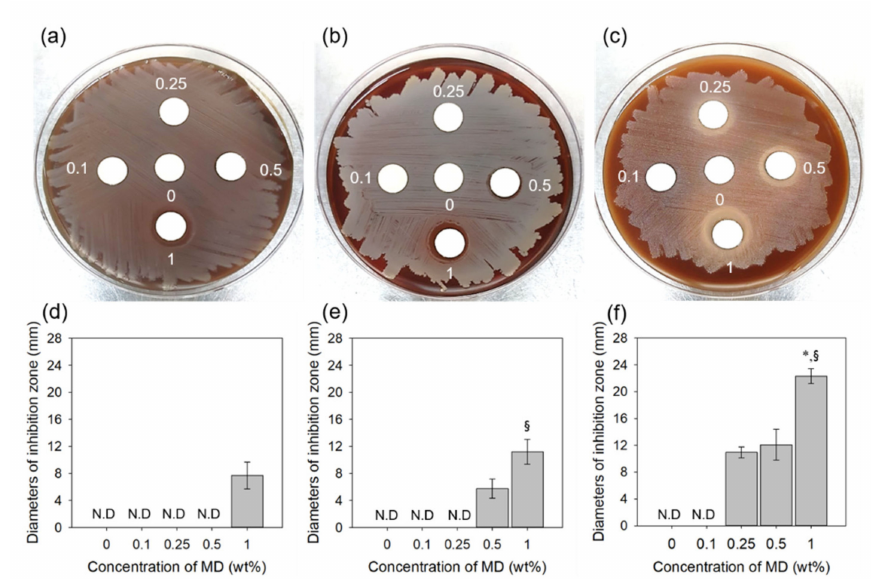
Figure11. Anti-bacterialactivityoftheMD / PAAhydrogelfilms: ( a , d ) Escherichiacoli , ( b , e ) Staphylococcus aureus , and ( c , f ) Streptocaccus mutans . (“*” indicates statistical significance relative to the 0.25 MD / PAA and “§” relative to the 0.5 MD / PAA, with p < 0.05), (N.D = Not